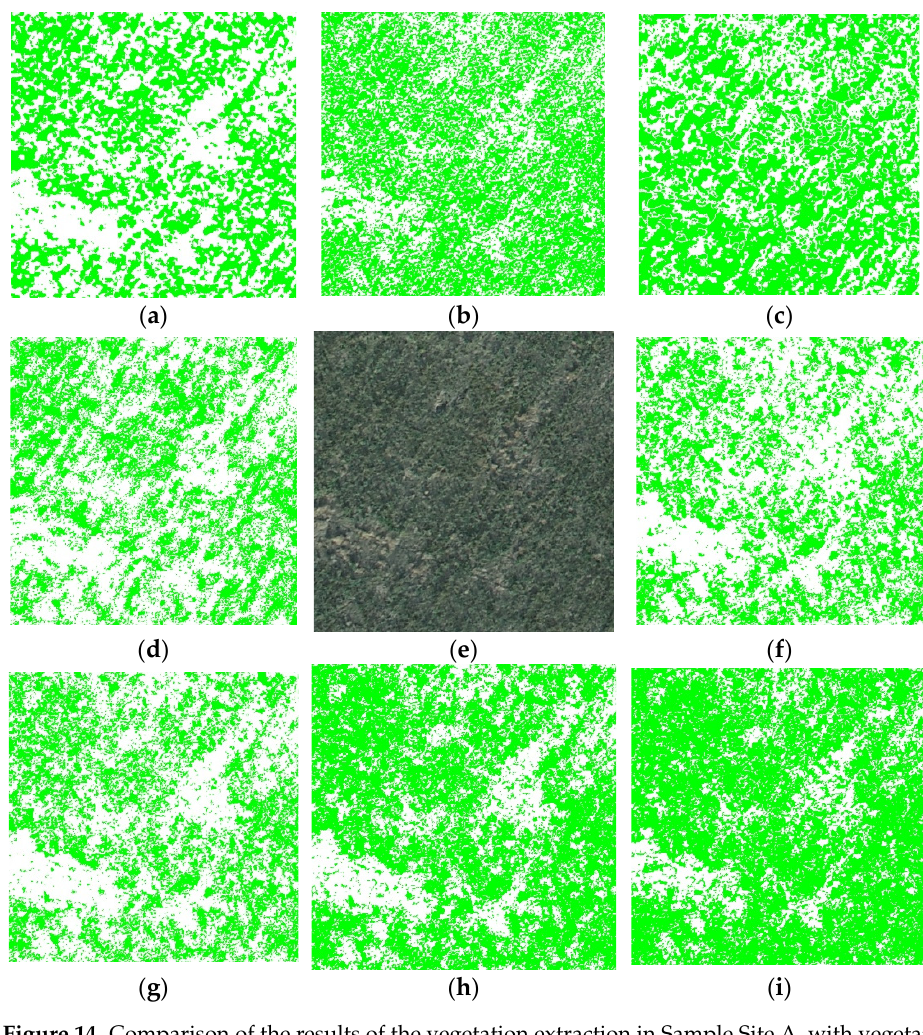
Figure 14. Comparison of the results of the vegetation extraction in Sample Site A, with vegetation in green. ( a ) EXG, ( b ) EXGR, ( c ) k-mean, ( d ) NGBDI, ( e ) RGB, ( f ) NGRDI, ( g ) VDVI, ( h ) truth, ( i ) svm.